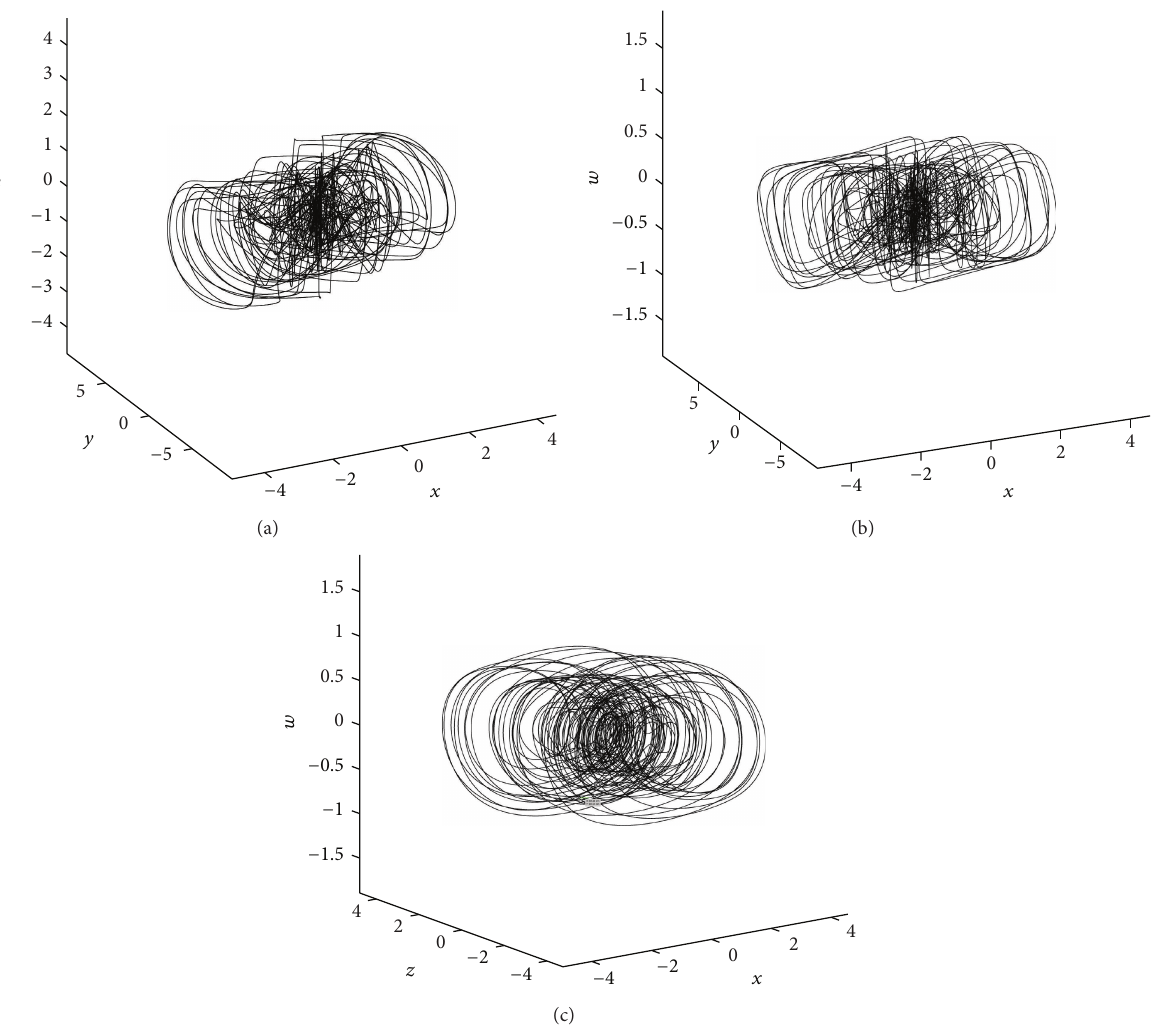
Figure 1: Attractors of the considered fractional-order system: (a) three-dimensional view (𝑥−𝑦−𝑧) ; (b) three-dimensional view (𝑥−𝑦−𝑤) ; (c) three-dimensional view (𝑥 − 𝑧 − 𝑤) .